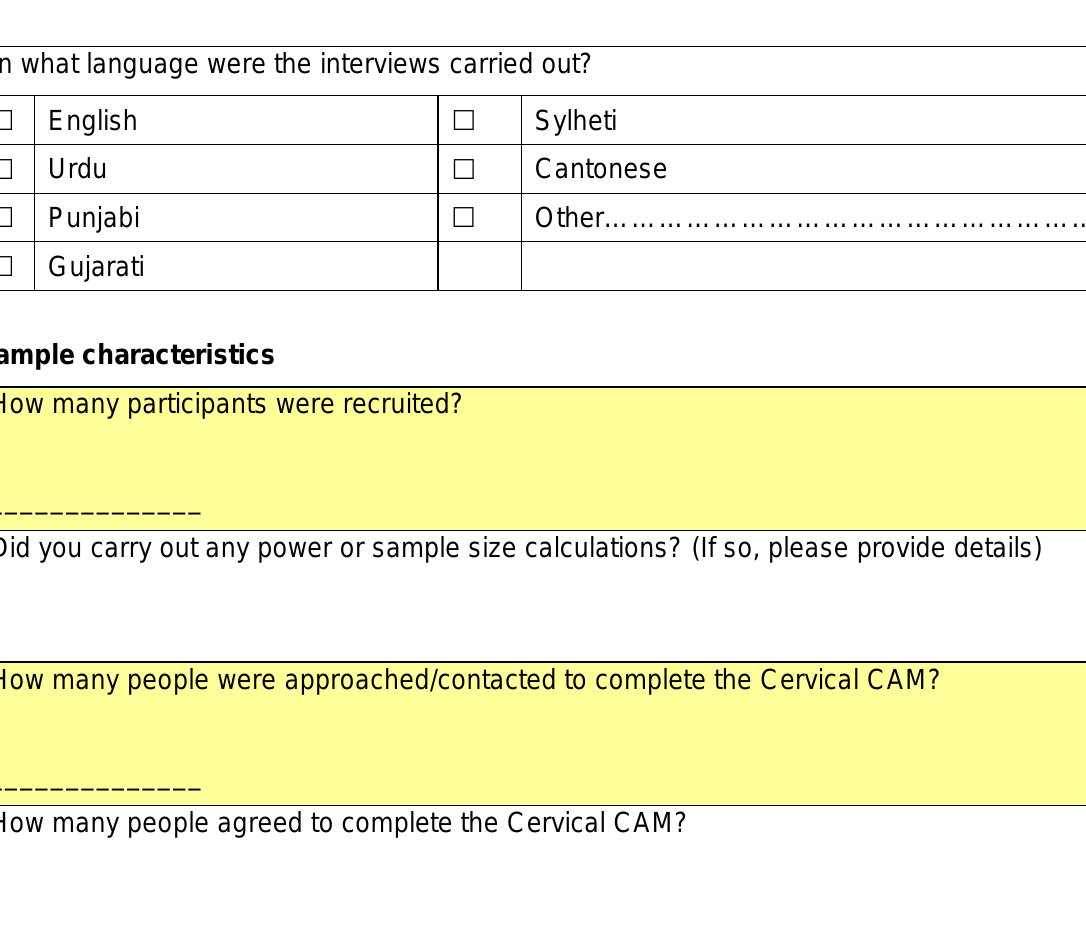
Cervical Cancer Awareness Measure Toolkit Version